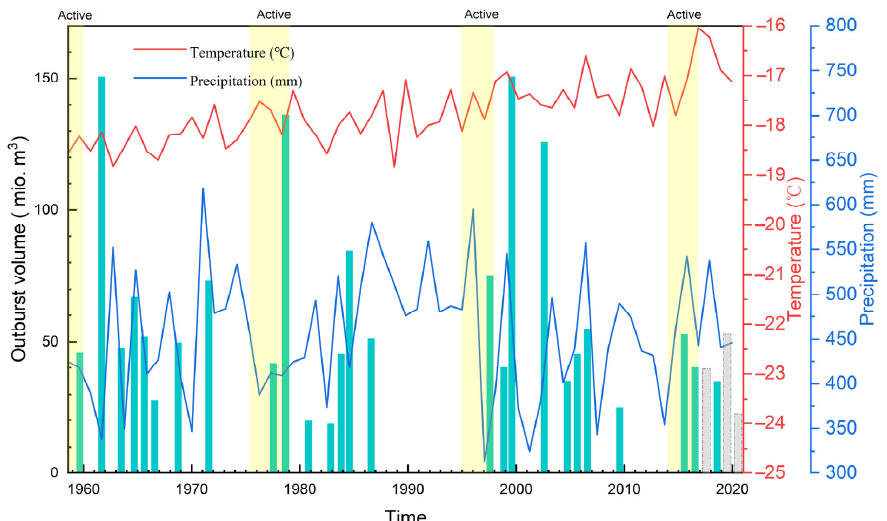
Figure 11. Glacial lake outburst volumes (columns) and annual temperature and precipitation times series from 1959 to 2020. The volumes were derived from (1) 1959–2016 = Round et al. [30], (2) 2018 = Zhang et al. [45], and (3) 2017, 2019, and 2020 = estimates of lake areas in satellite images according to the method of Round et al. [30]. Temperature and precipitation were derived from ERA5 data.